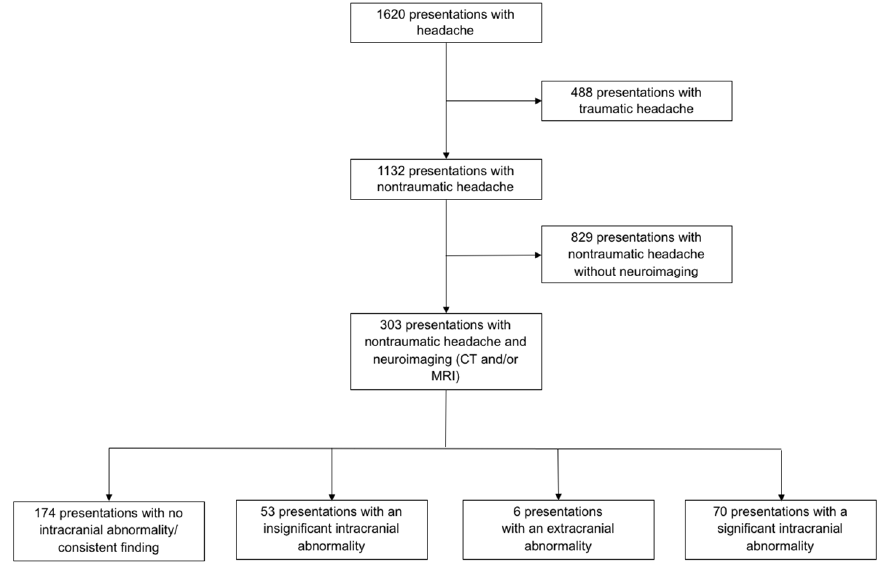
Figure 1. Study population.